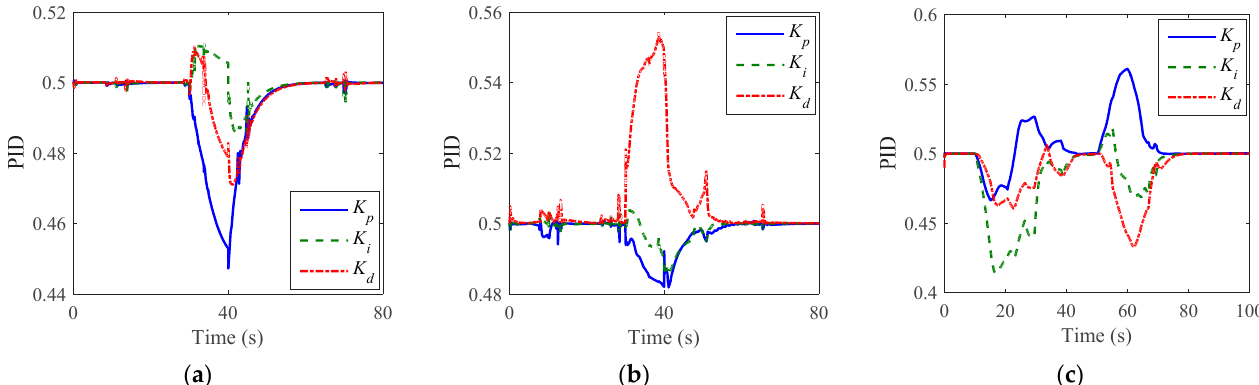
Figure 13. Diagram of PID parameter changes under three experimental conditions. ( a ) Scenario 1. ( b ) Scenario 2. ( c ) Scenario 3.